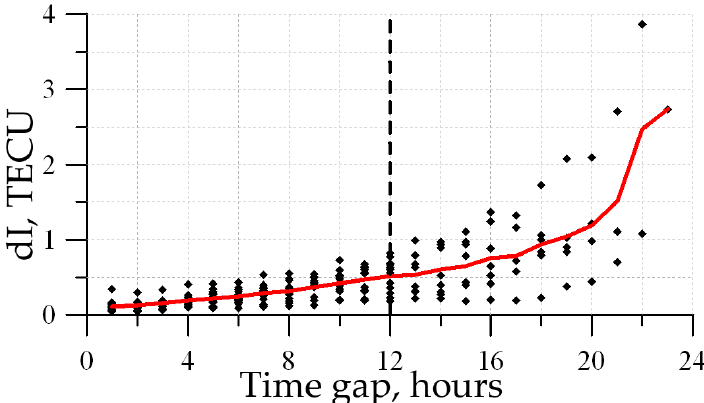
Figure 14. TEC determination error at different times, relative to the receiver’s first start. The dotted line marks the admissible interval, over which the suite retains the run mode.